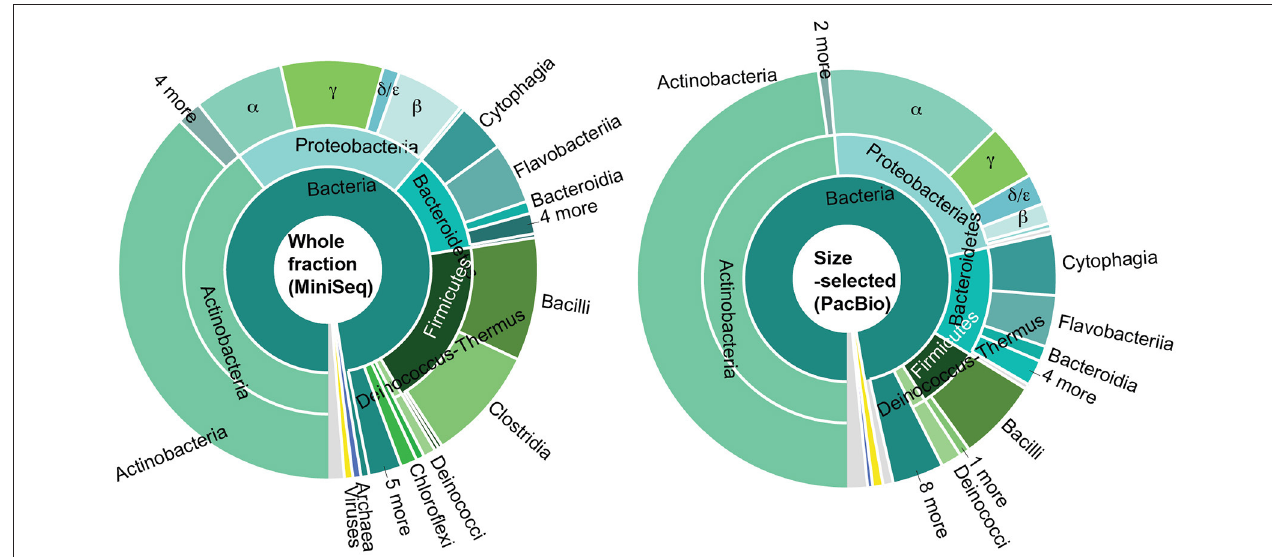
FIGURE 5 | Taxonomic distribution based on abundance of RNASeq reads (sum of TPM values) for communities represented in the whole fraction MiniSeq and size-selected PacBio